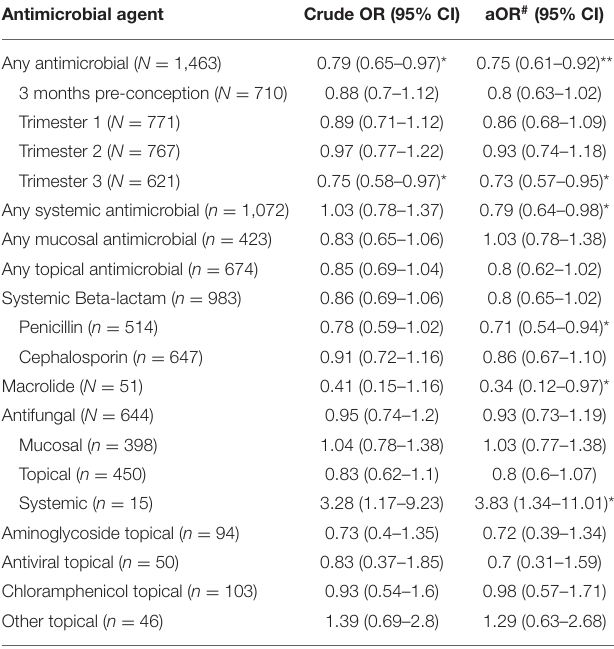
TABLE 3 | Crude and adjusted ORs for ASD of different types of antimicrobial agents in a multivariate model including background characteristics. Antimicrobial agent Crude OR (95% CI) aOR # (95% CI) Any antimicrobial ( N =